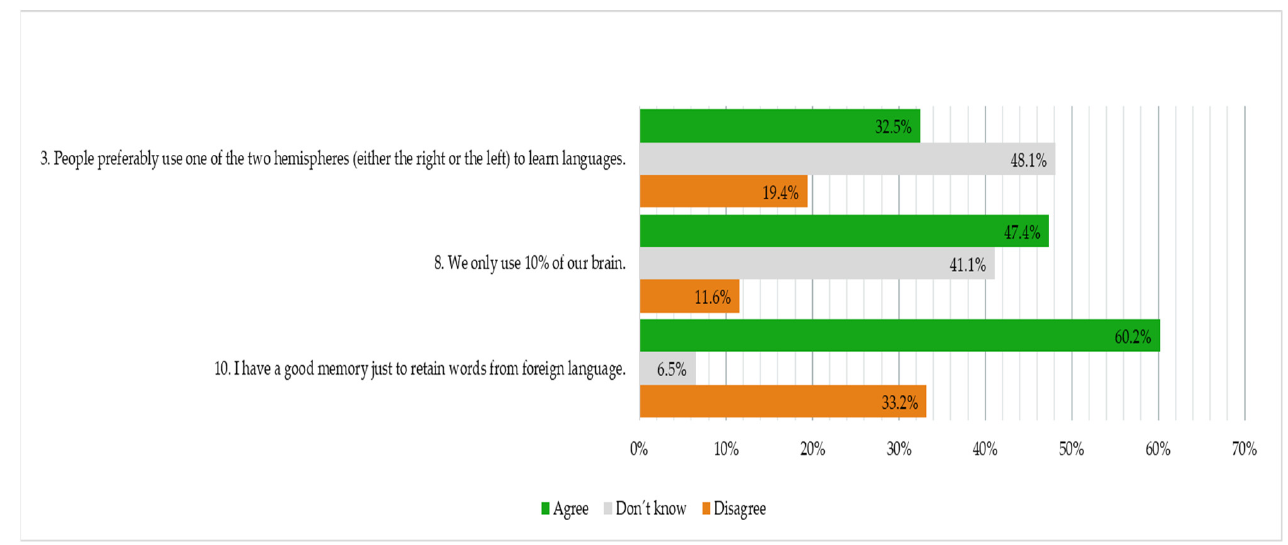
Figure 1. Frequency distribution of the items that make up Dimension 1. Functioning of the